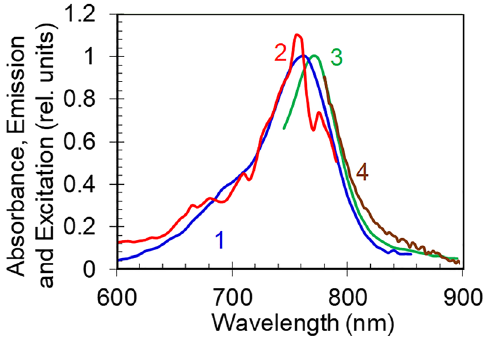
Figure 2: Absorption (trace 1), excitation (trace 2) and cw emission (trace 3) spectra of HITC:PMMA film on the glass substrate at a dye concentration of 8.5 g/l. Emission spectrum taken at short-pulse pumping (trace 4). Adopted from Ref.